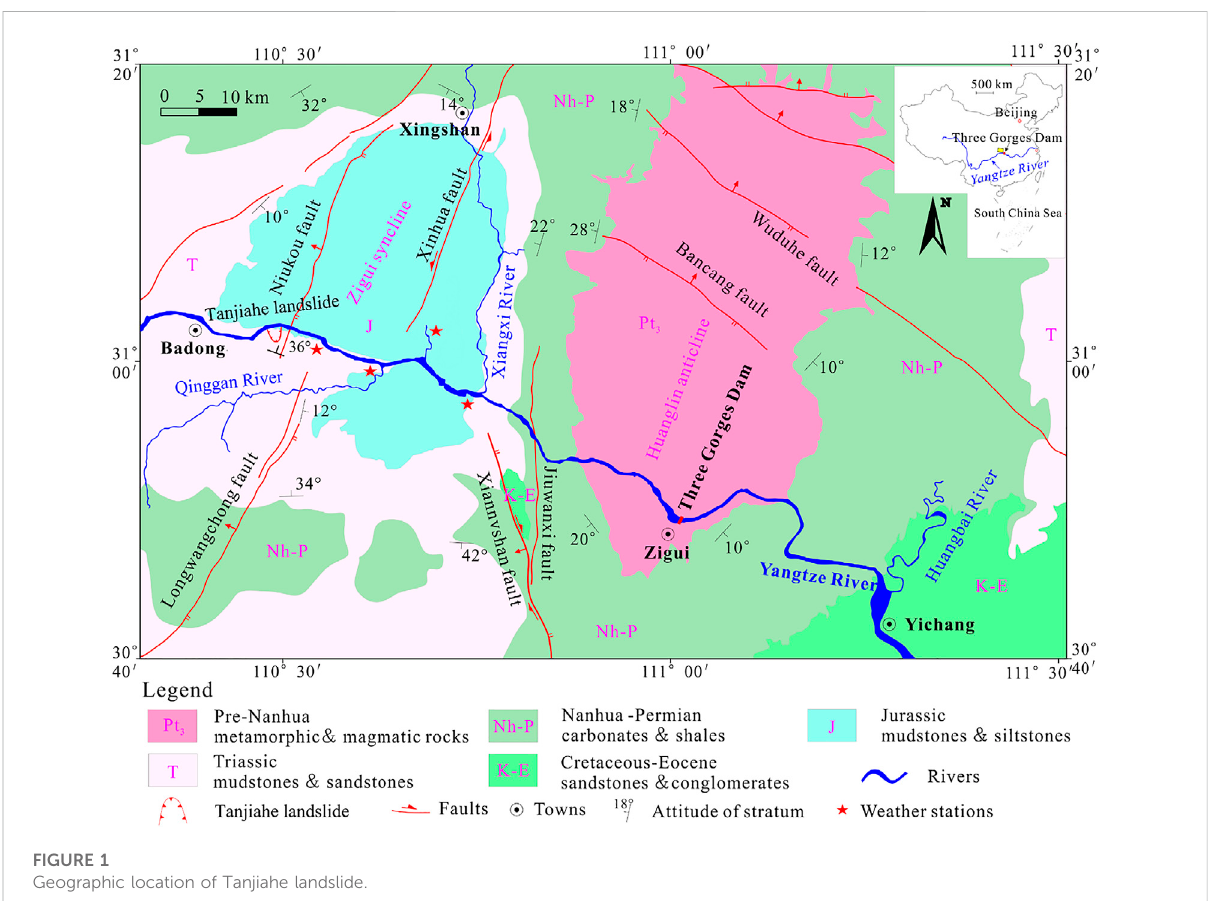
FIGURE 1 Geographic location of Tanjiahe